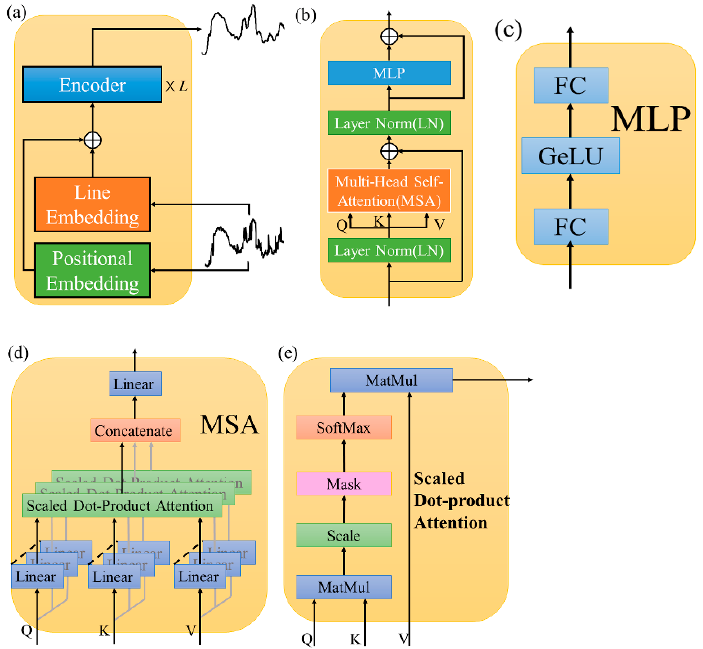
Figure 3. The architecture of the Transformer and its modules. ( a ) The architecture of the Transformer. ( b ) The architecture of the encoder. ( c ) The architecture of MLP. ( d ) The architecture of MSA. ( e ) The principle of scaled dot-product attention.